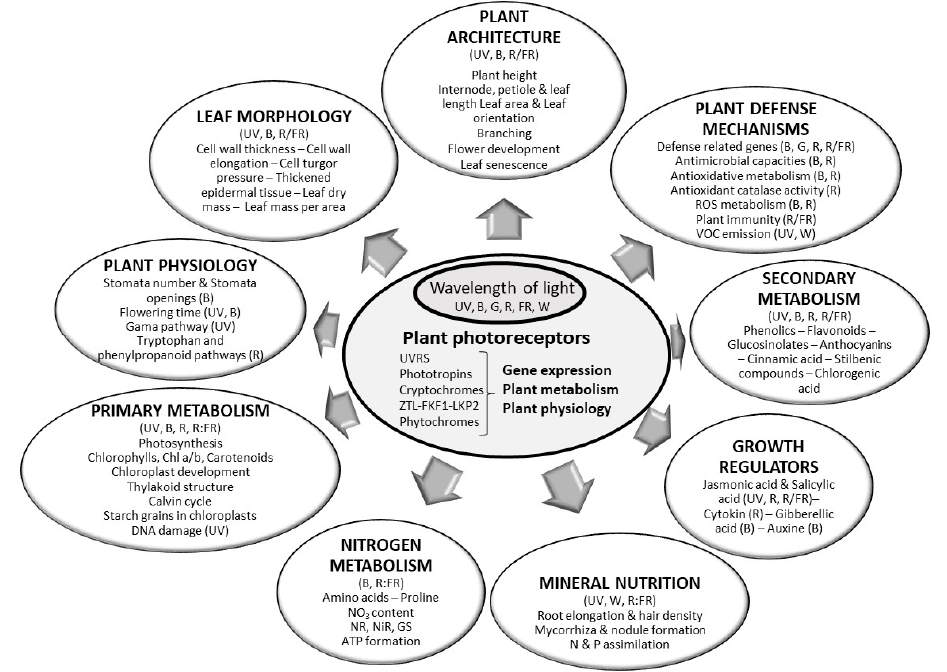
Figure 3. Plant processes affected by light that can be targeted to promote beneficial phyllosphere components, contributing to greenhouse crop productivity. ( Illustration: M. Dorais ).